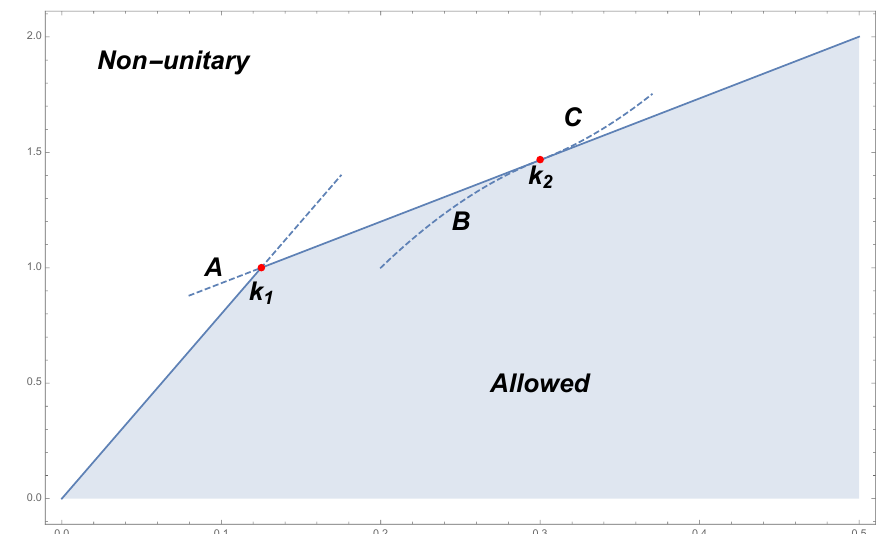
Figure 11 . Singularities and (cid:13)ows (schematic). At an ordinary kink, such as k 1 it is possible to (cid:13)ow into a non-unitary region, say along A , where some OPE coe(cid:14)cient becomes negative. However, not all decouplings of operators signal a visible kink. At when we approach k 2 from the left, an operator decouples. By allowing its OPE to become negative we can (cid:13)ow along C . Conversely, coming from the right, the functional develops a new zero at k 2 . If we do not input this new vector into the solution, the latter won’t be extremal anymore, and the (cid:13)ow will take us along B . This is a consistent thing to do, since at the singularity we have (cid:3) ( v (cid:3) ) = (cid:3) ( @ In particular, the linear dependencies guarantee that after the swap we will still have (cid:3) 0 ( @ d ) = (cid:3) 0 ( @ v (cid:3) ) = 0, so that these vectors are indeed singles satisfying the n d (cid:1) (cid:1)